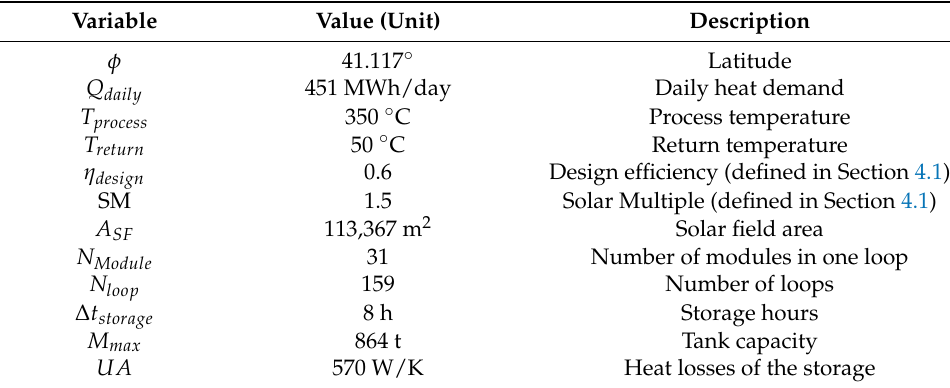
Table 1. Summary of the case study’s